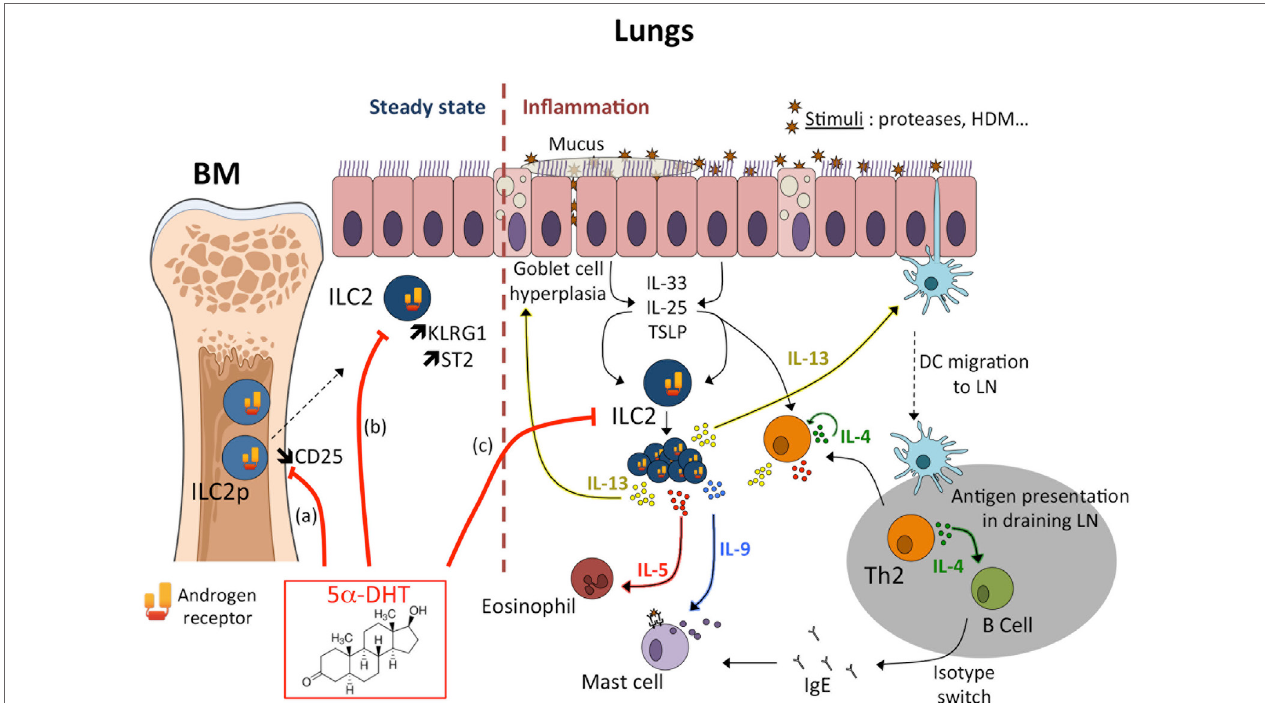
FiGURe 1 | Mechanisms of androgen-mediated inhibition of type 2 inflammation. Androgens mediate the decreased recruitment/proliferation of group 2 innate lymphoid cell (ILC2) responsible for the reduced development of type 2 inflammation in males compared to females. Androgen-signaling may act at multiple levels to limit ILC2 development at steady state and/or ILC2 response during inflammation. (a) At steady state, androgen (5 α -DHT) would limit the development of ILC2 progenitors (ILC2p) in the bone marrow (51). Whether this may negatively impact the seeding of ILC2 in peripheral tissues is unknown, as well as the period of life where this mechanism may occur. Enhanced CD25 expression in female ILC2p correlated with an increased frequency of proliferating (Ki67 + ) cells (51), suggesting that greater sensitivity to IL-2 in female ILC2p could promote ILC2 seeding in non-lymphoid tissues during ontogeny. This hypothesis is however not supported